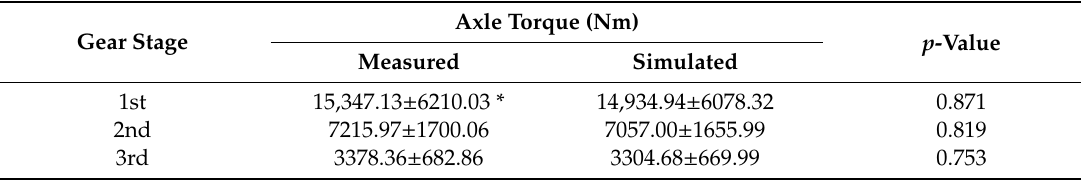
Table 3. Comparison of the axle torque between the measured and simulated results based on the gear stages .